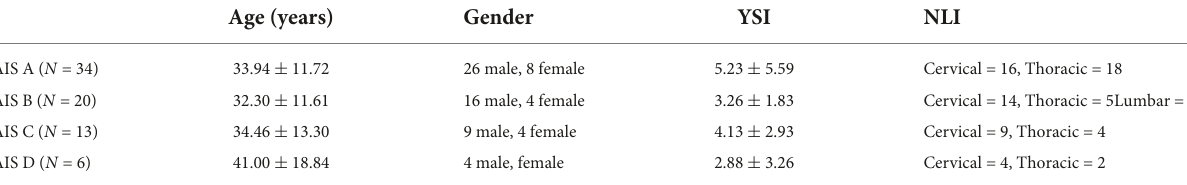
TABLE 1 Clinical characteristics of SCI